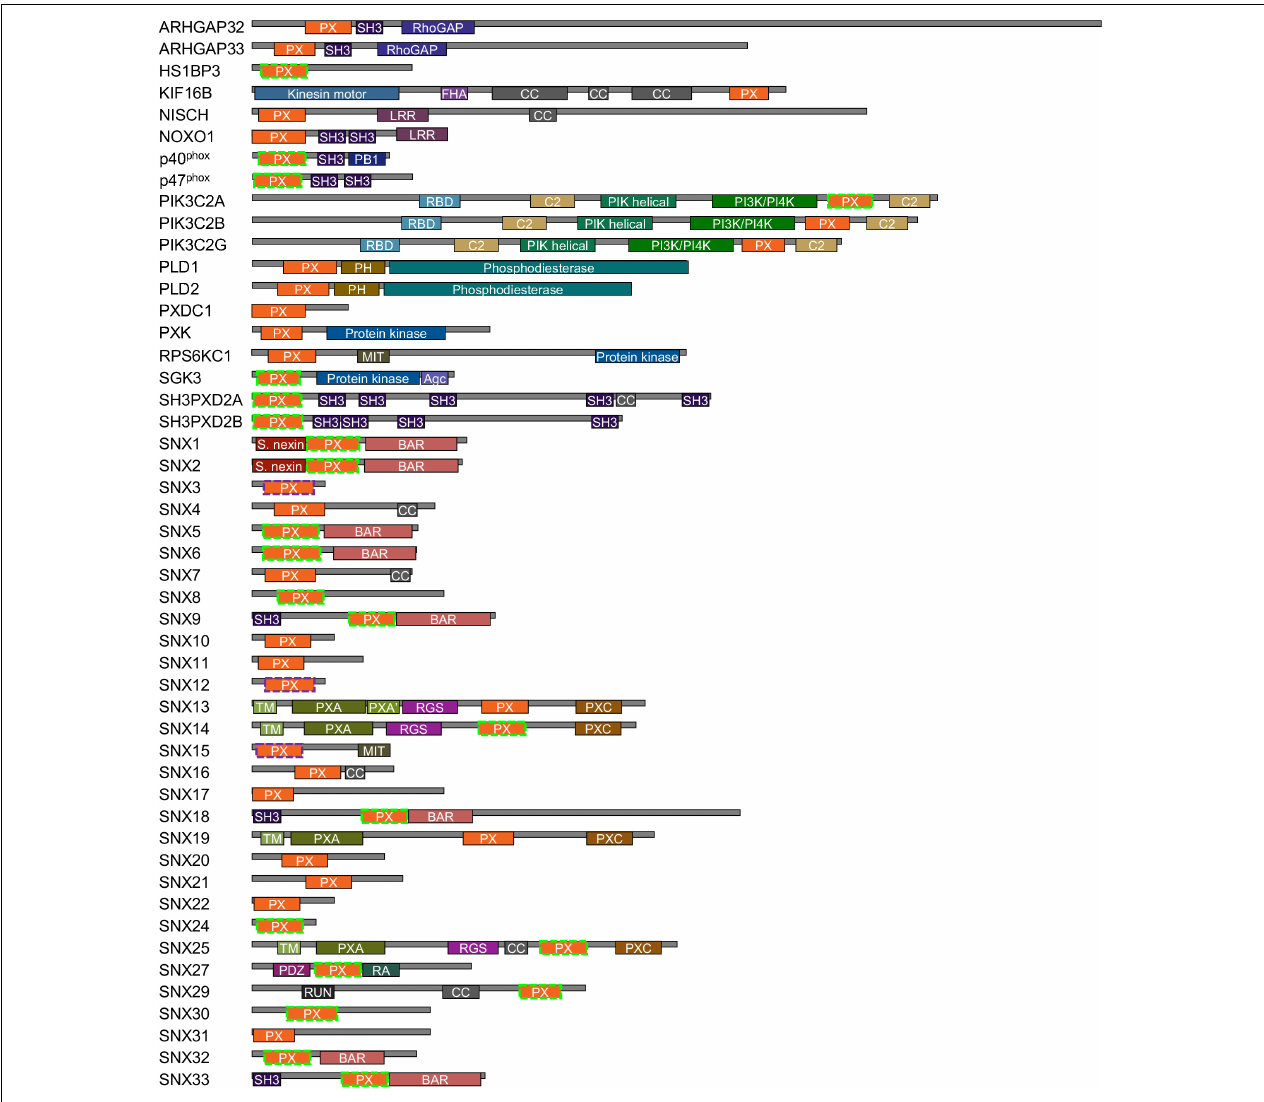
FIGURE 1 | Human proteins containing PX domains. The PX domains that contain arginine and lysine-based MET-stops are bounded by dashed purple and green lines, respectively. Modules are color-coded and abbreviated as Agc (AGC-kinase C-terminal), BAR (Bin–Amphiphysin–Rvs), C2 (protein kinase C conserved region 2), CC (coiled coil), GAP (GTPase-activating protein), FHA (forkhead-associated), LRR (leucine-rich repeat), MIT (microtubule interacting and transport), PB1 (Phox and Bem1), PDZ (Postsynaptic density 95, Disk large, Zonula occludens), PH (pleckstrin homology), PIK (phosphoinositide 3-kinase), PXA (PX-associated), PXC